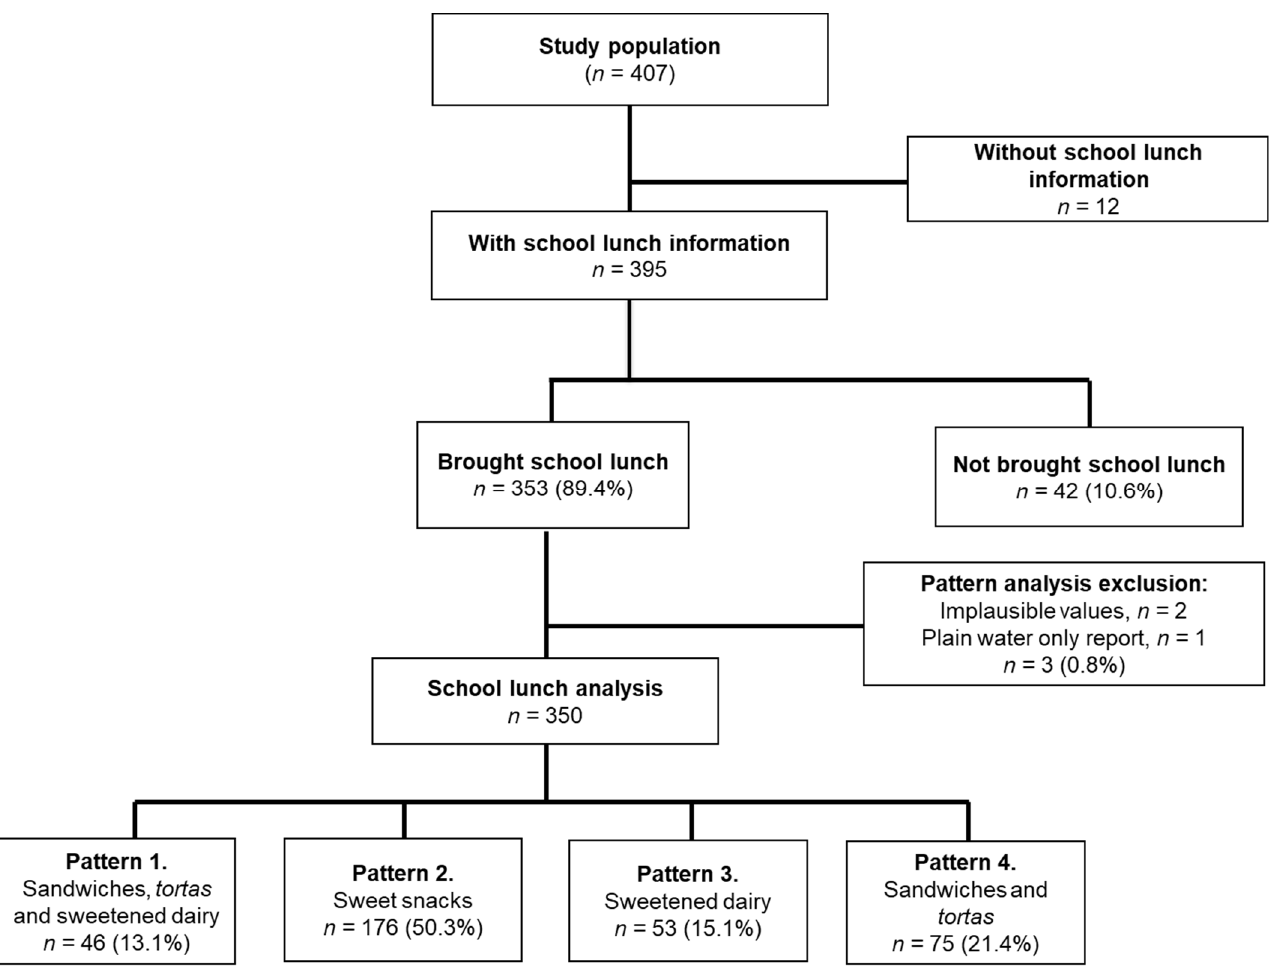
Figure 1. Diagram of the study population.